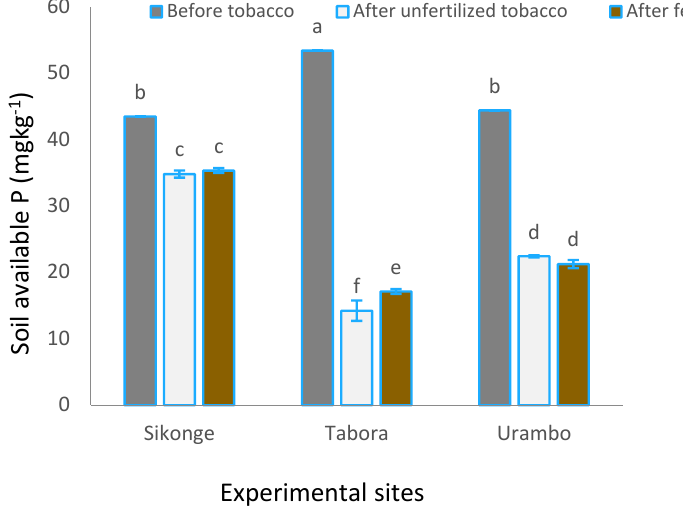
Figure 4. Effect of tobacco and fertilization on soil P. ‘a’ is very highly significant; ‘b’ is highly significant; ‘c’, ‘d’ & ‘e’ are significant; ‘f’ non significant.